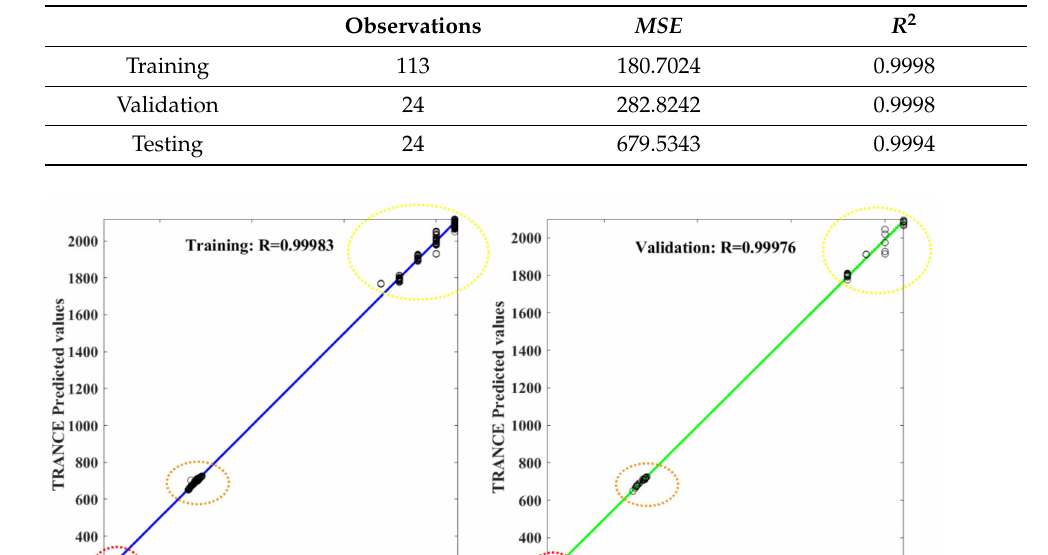
Table 3. Performance of the developed TRANCE model for three zones.